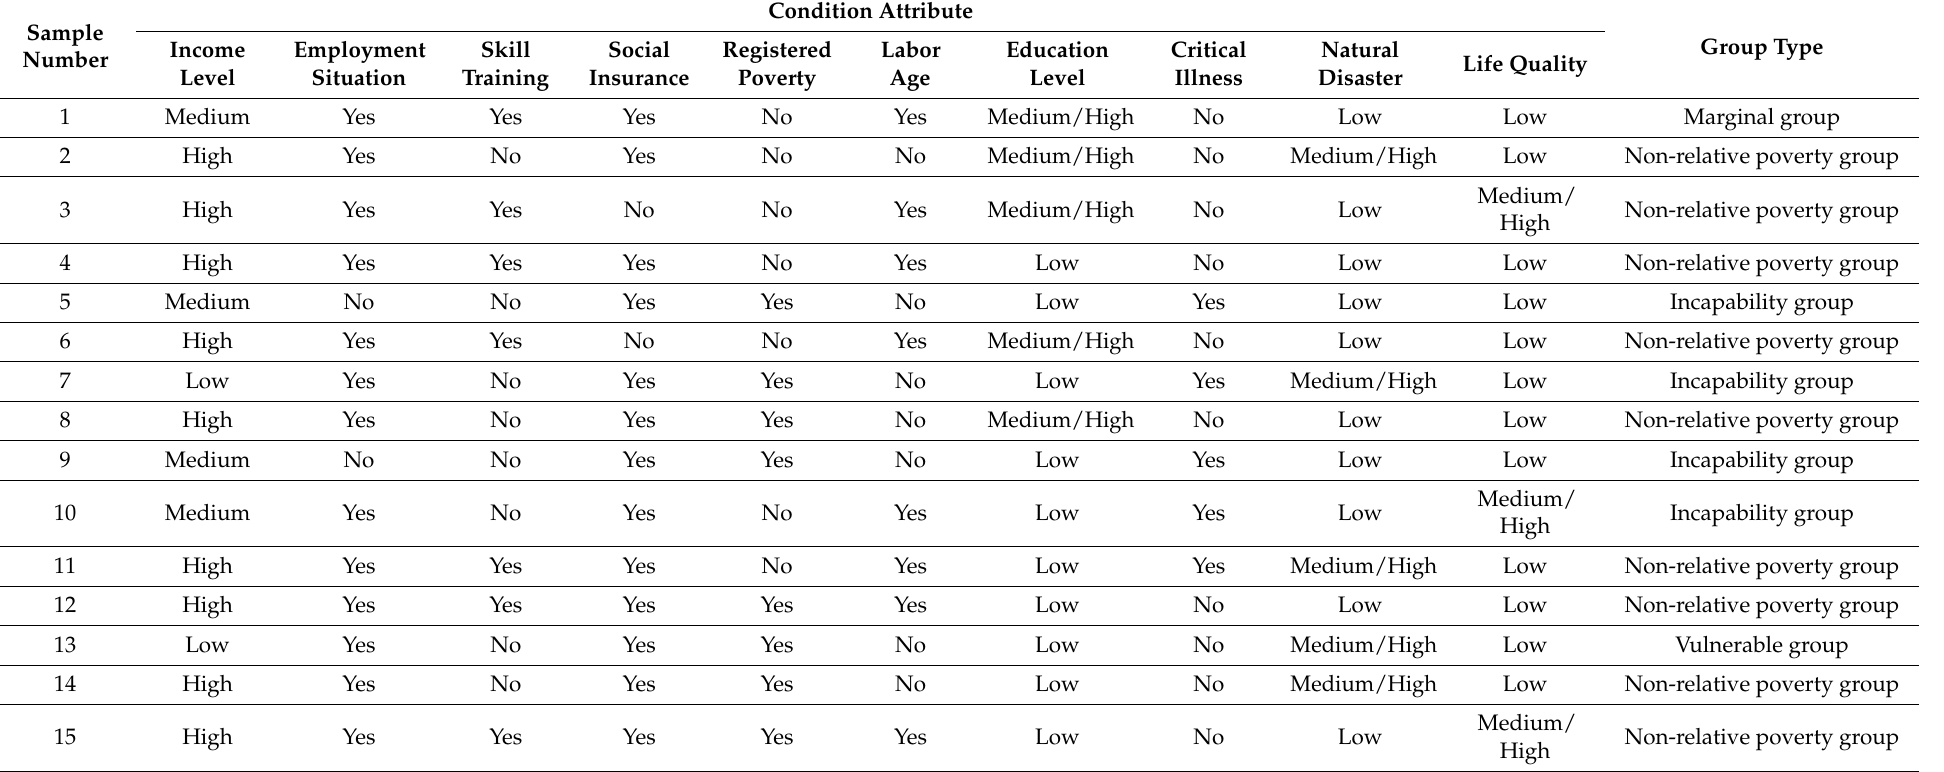
Table 1. Sample dataset for evaluation of relative poverty groups